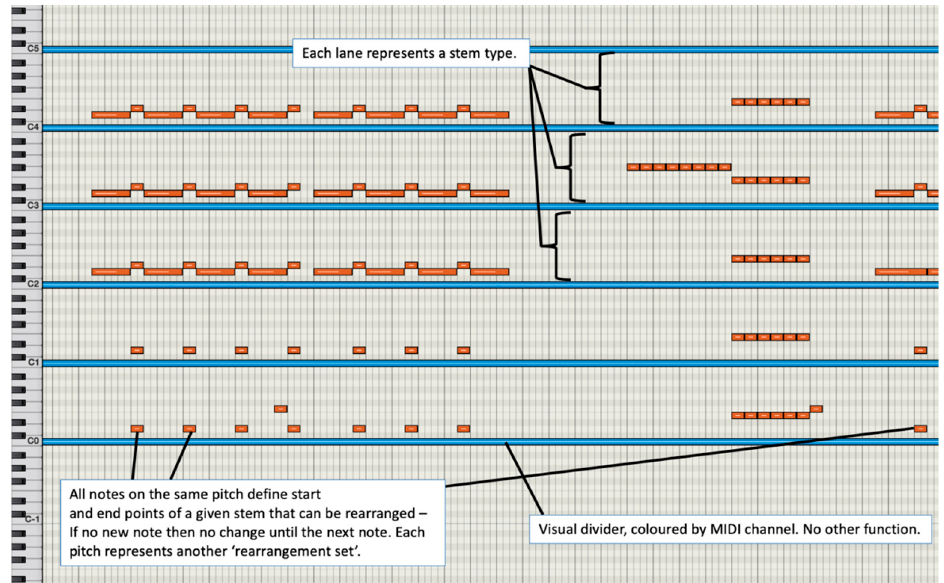
Figure 13. The digital audio workstation (DAW)-based piano-roll view of how a user might define time windows for juxtaposition.